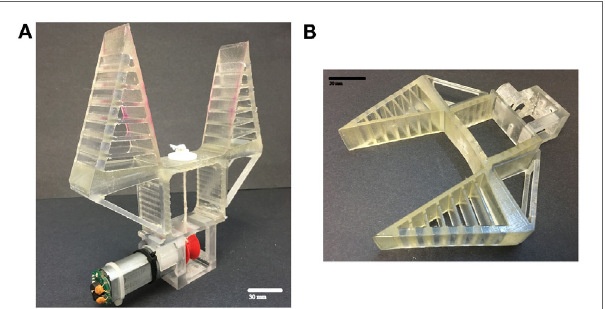
FigUre 2 | The Tihra gripper is composed of hard and soft parts and printed as one part on a connex Objet500 3D printer . (a) The TIHRA gripper with motor and tendon/pulley system attached. (B) The older version of the TIHRA gripper that competed in the RoboSoft Grand Challenge. FigUre 3 | Front view of the Tihra gripper with labeled parts . Hard